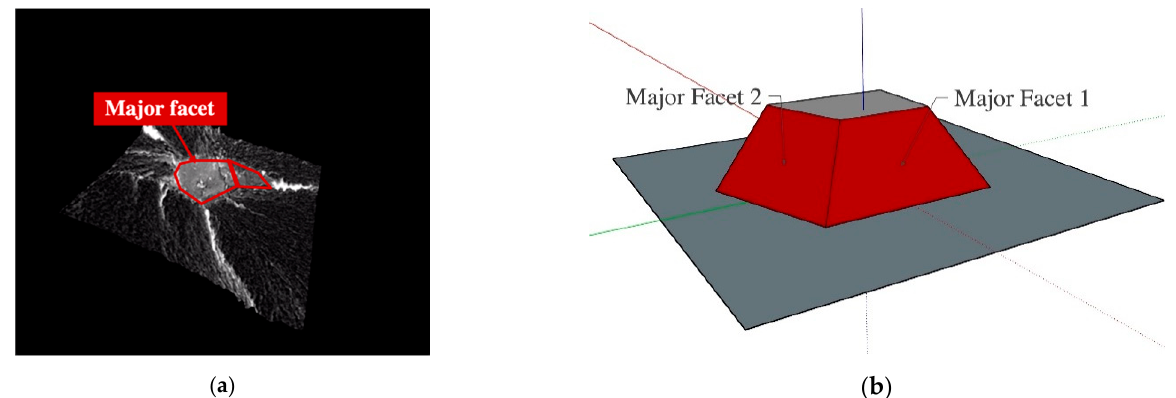
Figure 10. Example of the peak type. These facets are the same facets shown in Figure 6c ( (cid:2026) (cid:3040)(cid:3028)(cid:3051) = 1000 MPa, R = 0.1, N f = 3.0 × 10 5 ). ( a ) 3D-SEM image; ( b ) 3D-model schematic image.